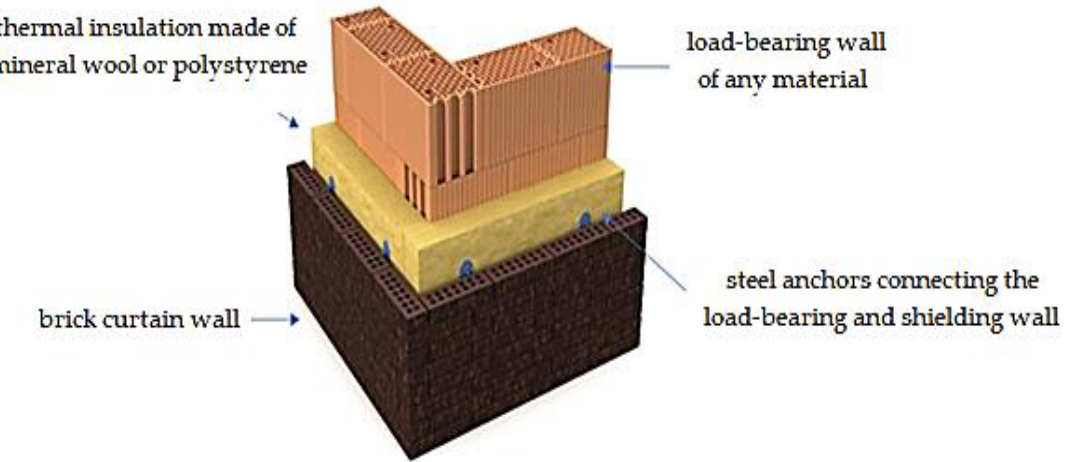
Figure 1. Construction of a three-layer wall. Source: own study.